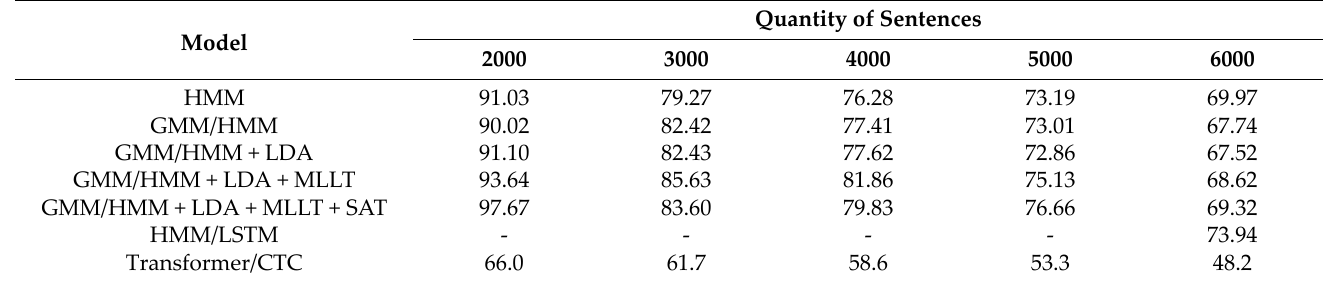
Table 4. CER of different acoustic models recognizing different quantities of sentences.